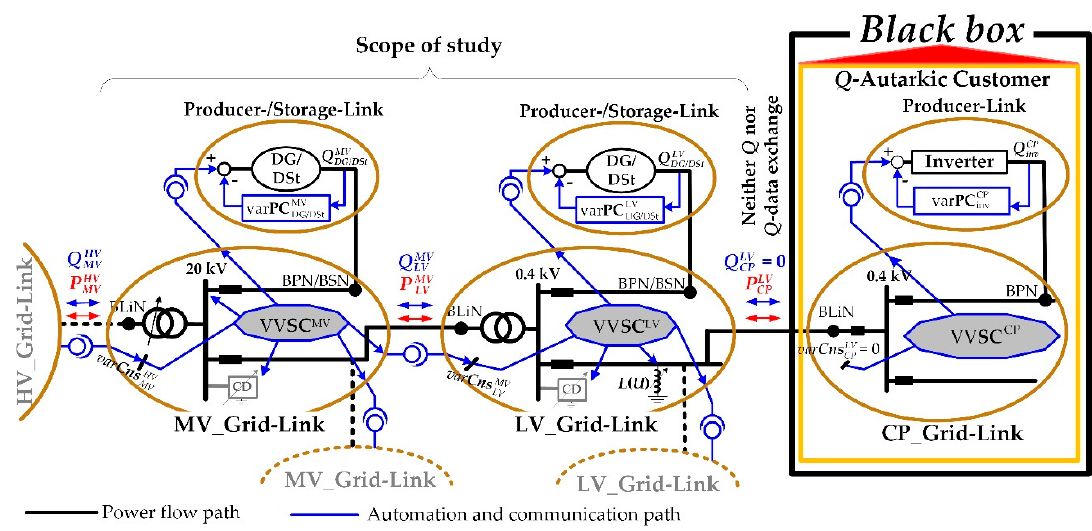
Figure 1. The generalized form of the volt / var control chain strategy implying the L ( U ) + Q -autarky control ensemble.